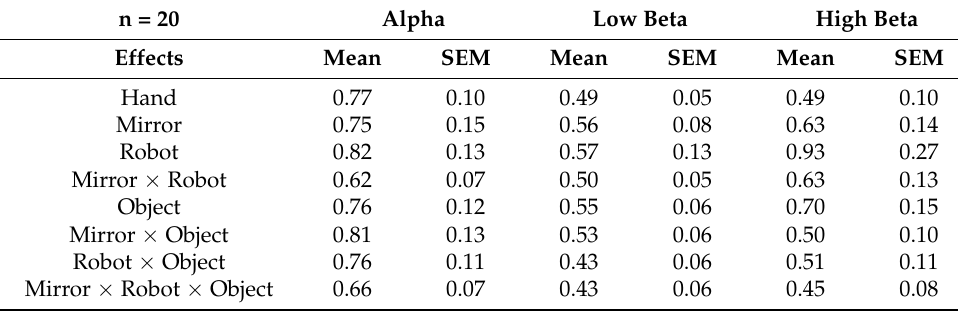
Table 2. Interhemispheric coherence sum in the onset ≤ 1 year group.